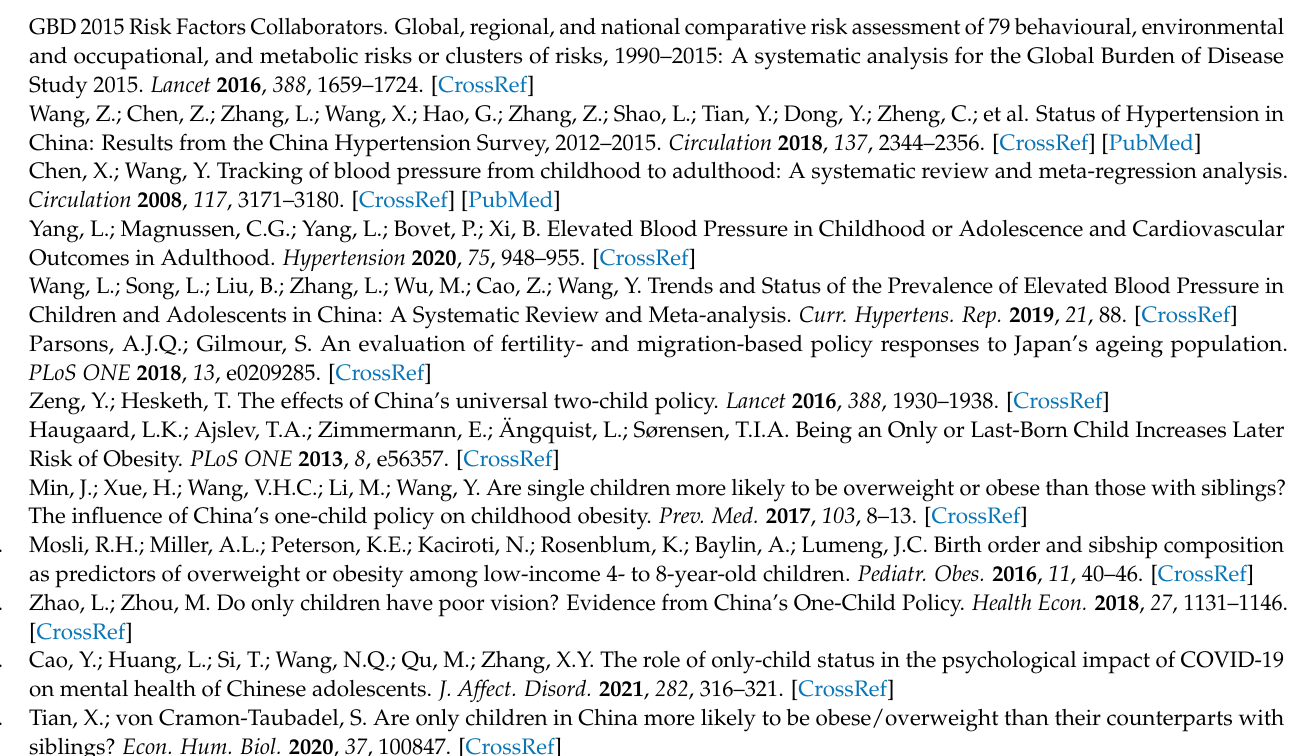
Table S3: Mediation of lifestyle behaviors on the association between single-child status and BP in boys ( n = 25,661), Table S4: Moderation of lifestyle behaviors on the association between single- child status and BP z score in boys ( n = 25,661), Table S5: Moderation of lifestyle behaviors on the association between single-child status and HBP in boys ( n =